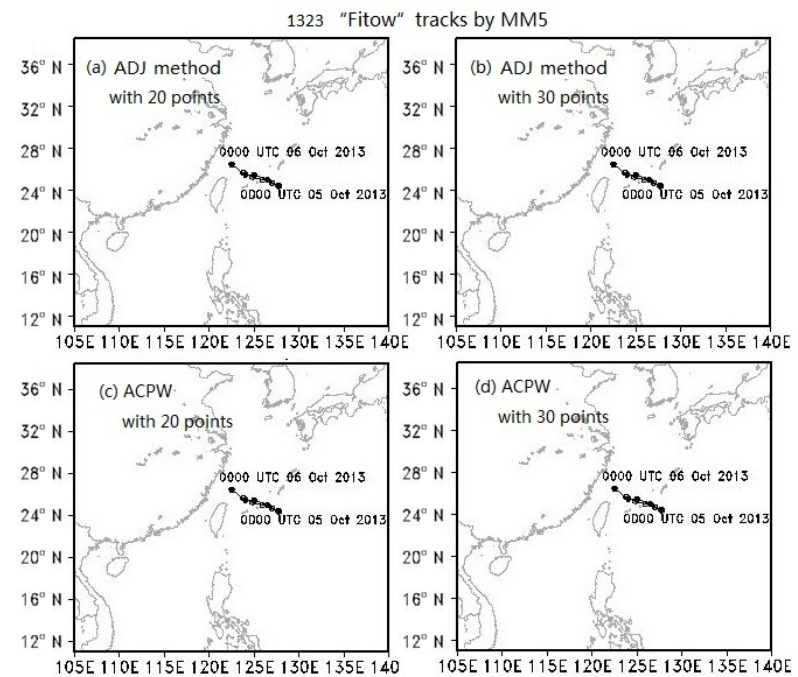
Figure 17. Simulated TC tracks from MM5 through the insertion of the amended CNOPs, which are reduced by a factor of 0.5 only in the sensitive regions, into the initial state for TC Fitow. Solid circles represent the observed TC tracks from the CMA, and the hollow circles show the simulated TC tracks from the MM5 model. (a) , (b) , (c) and (d) denote the ADJ method with 20 points, ADJ method with 30 points, ACPW algorithm with 20 points and the ACPW algorithm with 30 points,